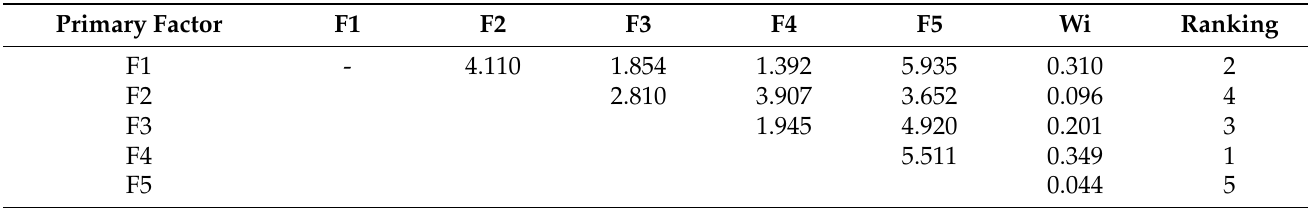
Table 7. Priority ranking of primary factors.